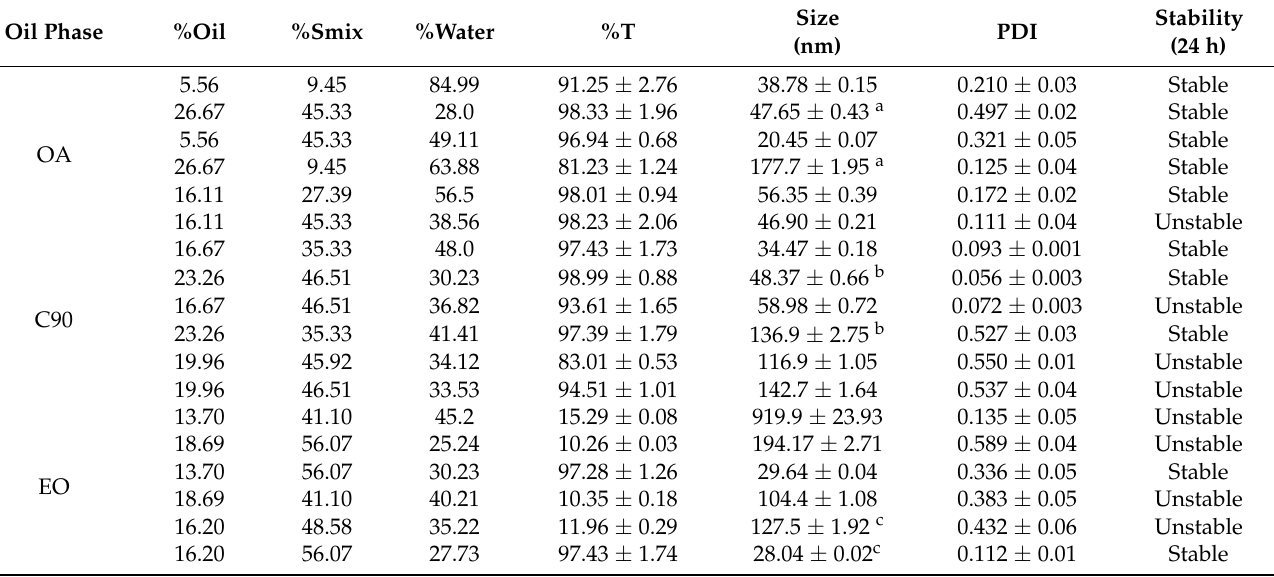
Table 2. Percentage composition of NEs prepared by spontaneous emulsification method and the impact on the formulation droplet size, PDI, and the stability (mean ±